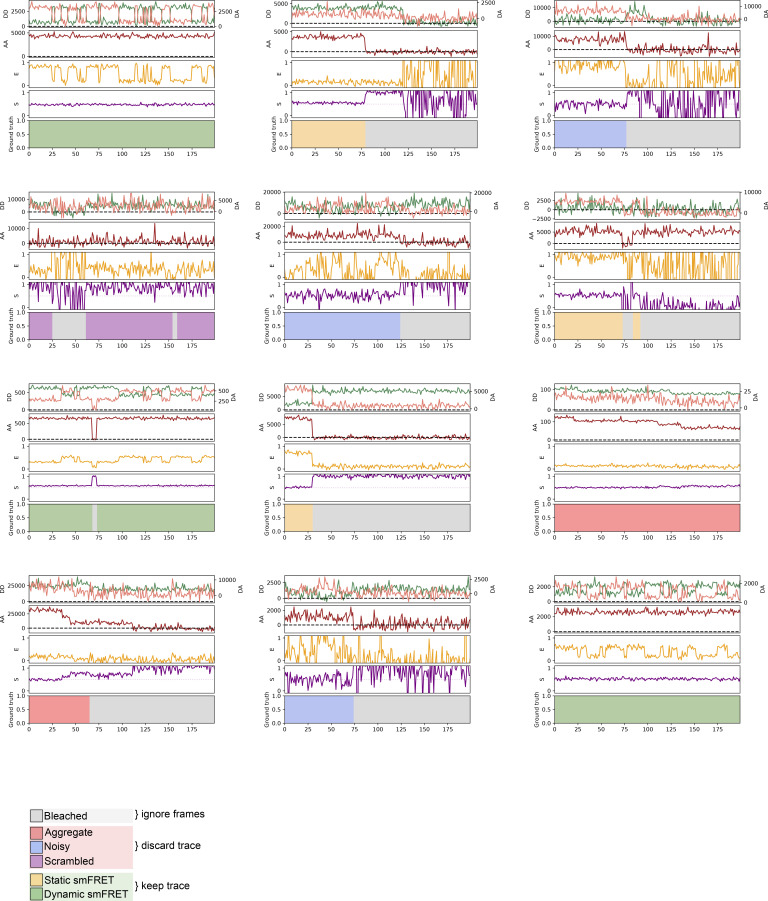
Examples of randomly generated traces.Randomly generated traces, corresponding to each of the six defined categories, shown with raw signals, E (FRET), and S (stoichiometry). The color code in the bottom panel corresponds to the frame-level ground truth labeling of each trace.